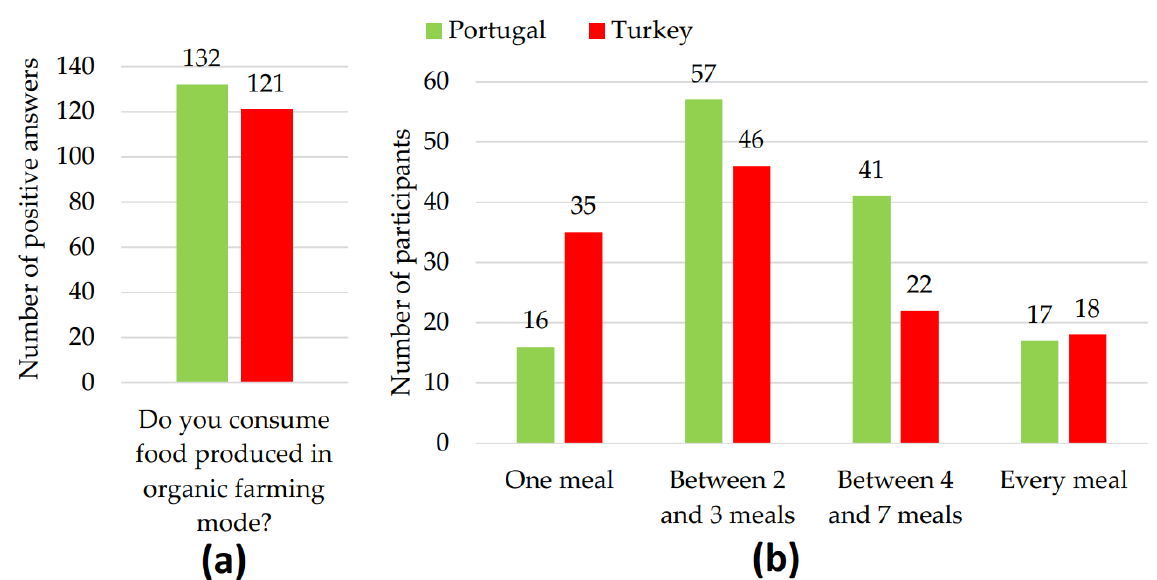
Figure 1. Consumption of organic foods in both countries on a typical week: ( a ) participants who consume organic foods; ( b ) Frequency of consumption.